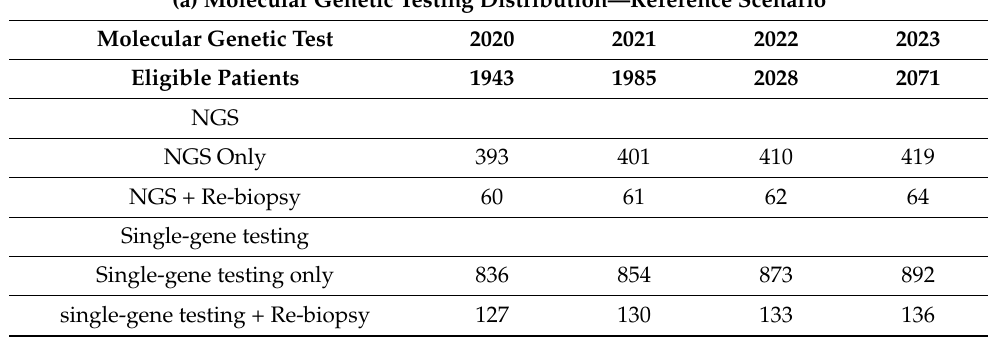
Table 2. ( a ) Molecular genetic testing distribution—reference scenario. ( b ) Molecular genetic testing distribution—new